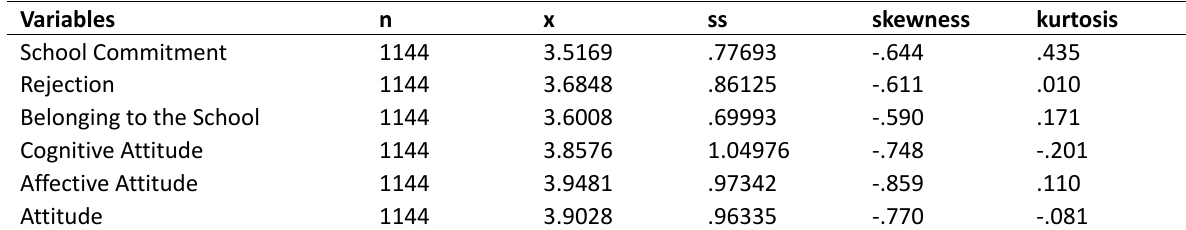
Table 1. Descriptive statistics of attitude and school belonging dimensions to physical education course Variables